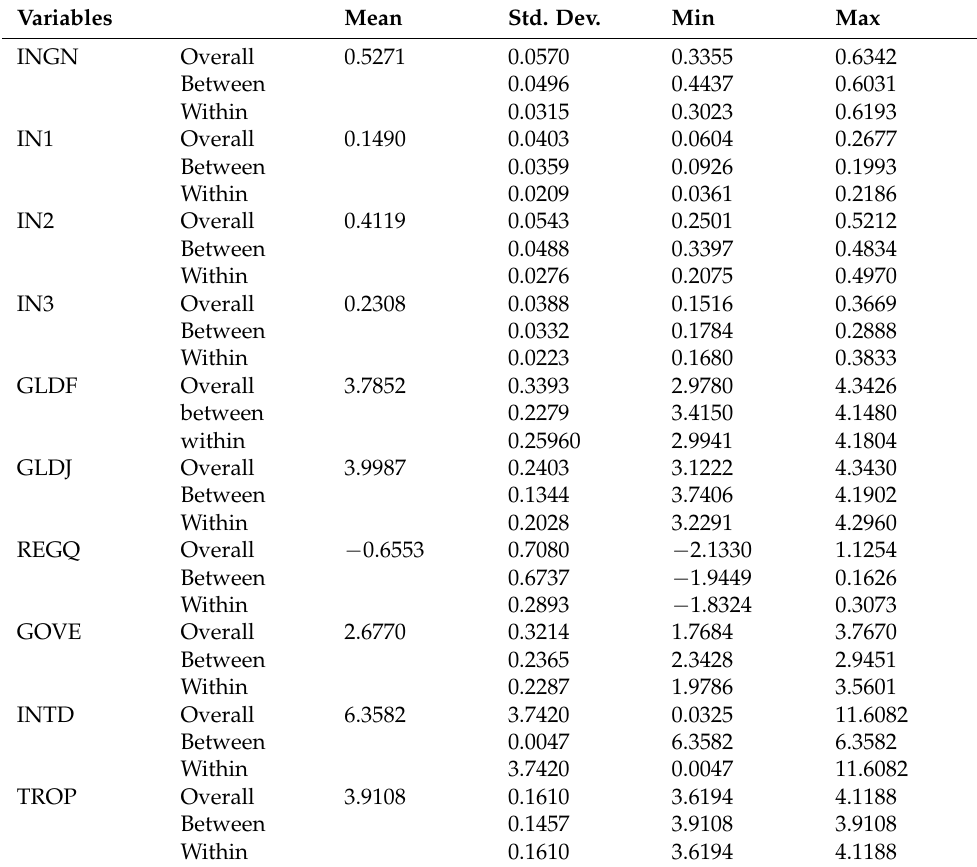
Table 2. Descriptive